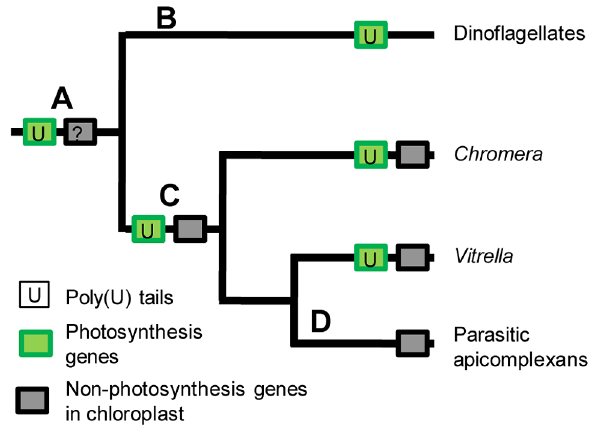
Figure 8. The evolution of transcript polyuridylylation in the alveolates. This schematic figure shows the evolutionary history of the chloroplasts of dinoflagellates, apicomplexans, and chromerids . The phylogenetic relationships between each lineage are given as per [11]. The content of each associated chloroplast genome is depicted by shaded boxes on each branch. The polyuridylylation of chloroplast transcripts is likely to have arisen once, in a common ancestor of all four lineages, which contained both photosynthesis and non-photosynthe- sis genes in its genome (point A). Following their divergence from the other three lineages, dinoflagellates relocated all non-photosynthesis genes to the nucleus, leaving only photosynthesis genes, of which almost all possess an associated poly(U) site (point B). As a result, it is not possible to determine whether the chloroplast polyuridylylation machinery was initially applied to all chloroplast transcripts, or only to photosynthesis gene transcripts; however, the polyuridylylation ma- chinery of the last common ancestor of chromerids and apicomplexans was certainly specific to photosynthesis genes (point C). While this situation has broadly remained true in each chromerid lineage, the apicomplexans have subsequently lost both photosynthesis genes and the associated chloroplast transcript processing machinery from their chloroplast (point D).